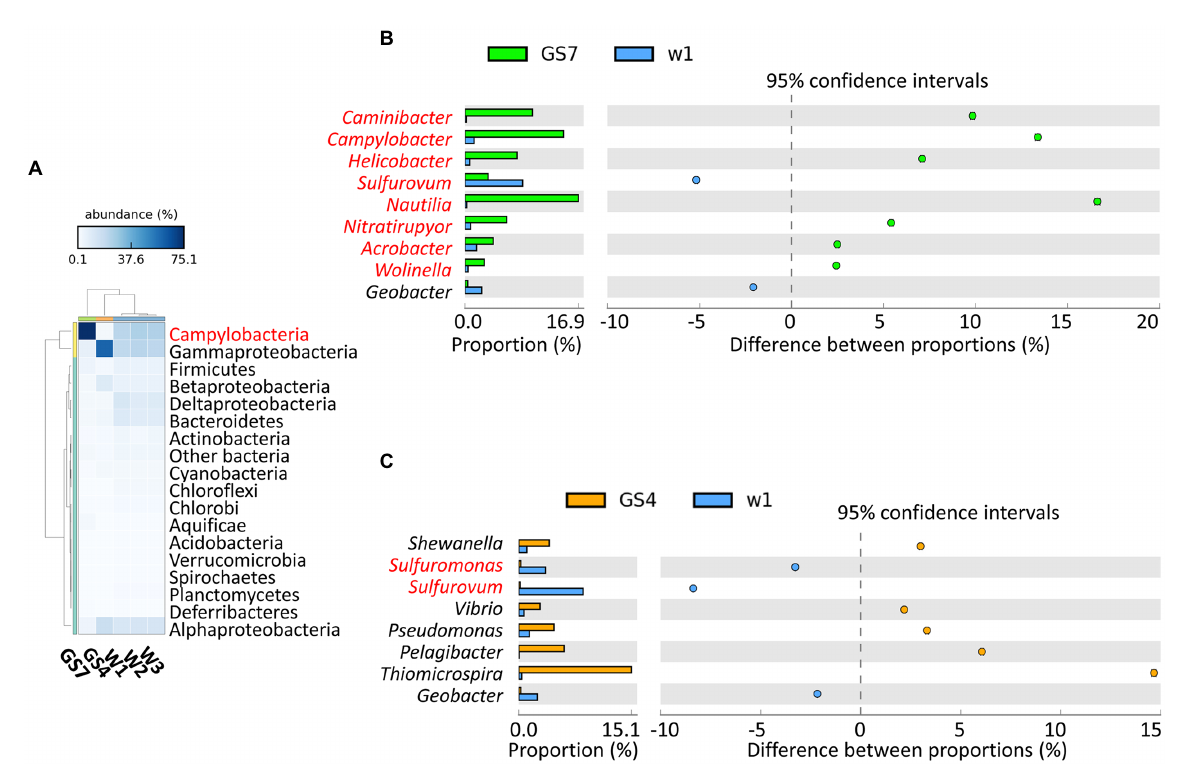
FIGURE 1 The taxonomic profile of typical phyla or classes (for Proteobacteria) (A) and extended error bar plot for the bacterial genera that have a difference of at least 2% between the vent fluid (GS7) or surface seawater (GS4) with sediment sample W1 (B,C) . “Other bacteria” in the phylogenetic classification include those with abundance<0.5% of total bacteria. The genera in red belonged to